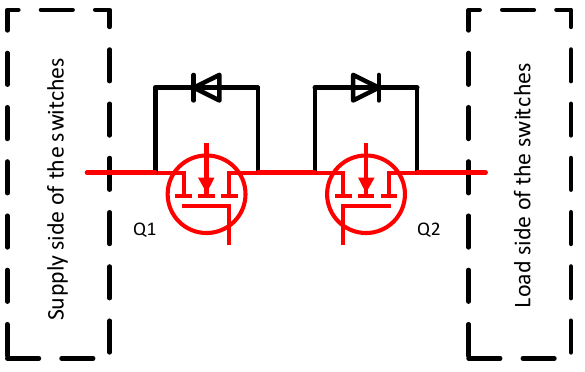
Figure 2. Current flow in SiC-based bidirectional switch.